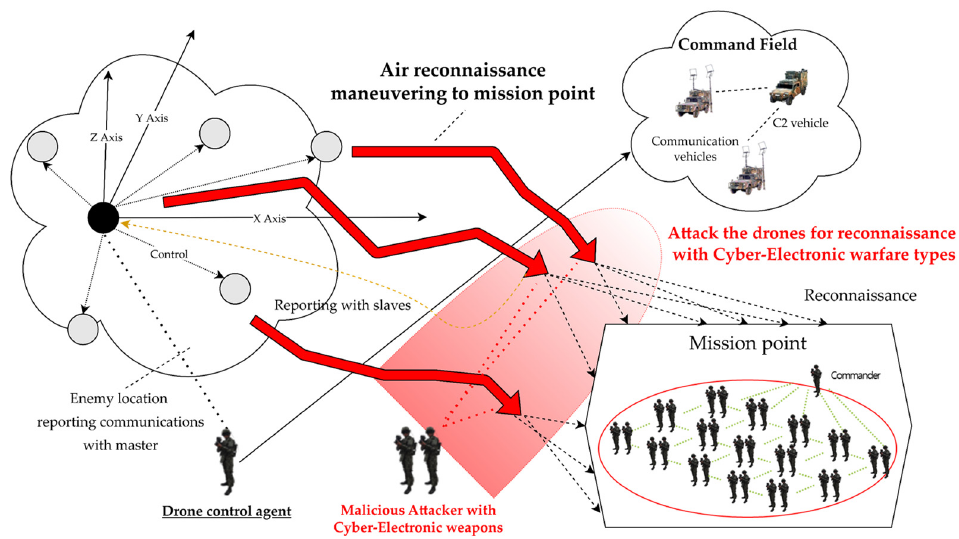
Figure 3. Sub-overview of swarming communication blue drones for reconnaissance in D-CEWS (DEVS-based cyber-electronic warfare).